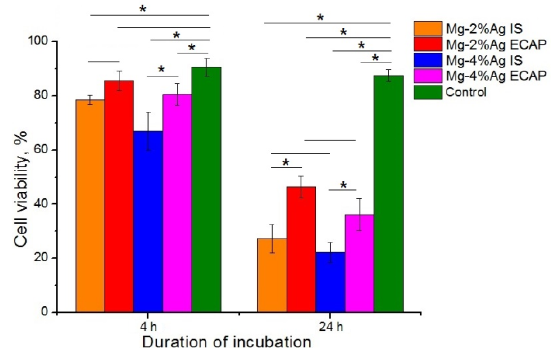
Figure 7. Effect of Mg-2.0%Ag and Mg-4.0%Ag alloys in the initial state (IS) and after ECAP (regime 2) on the viability of tumor cells (* p < 0.05).